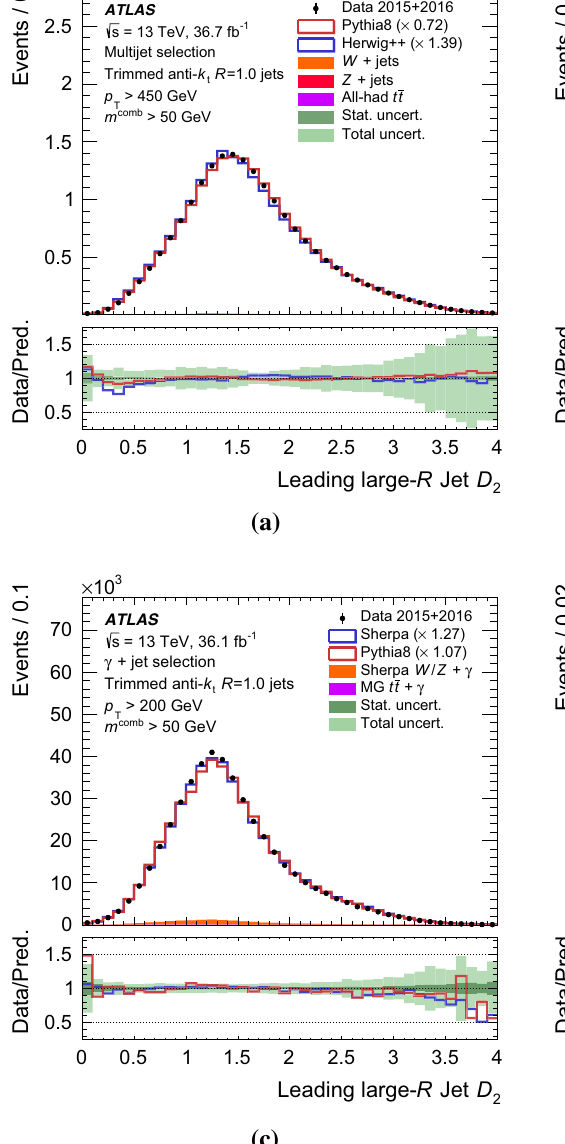
ple to which it applies. Systematic uncertainties are indicated as a band in the lower panel and include all experimental uncertainties related to the selection of events, as well as the reconstruction and calibration of the large- R jet